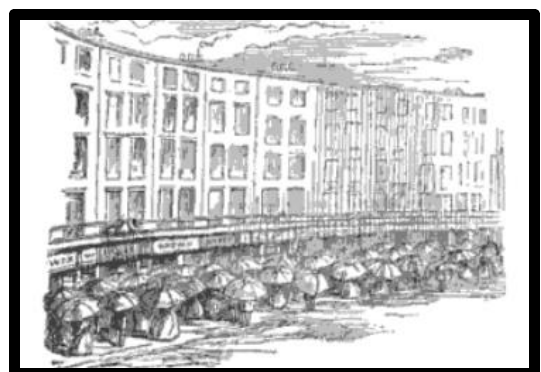
Figure 18: The Punch Magazine. (Vol XIV, 1848). The fall of the Quadrant. As can be seen in Figure 18, society still keeps the memory of shelter of the quadrant, and they produce their own route on a rainy day. The fact behind the social reproduction is based on practising the built environment. Practitioners are the daily actors that are